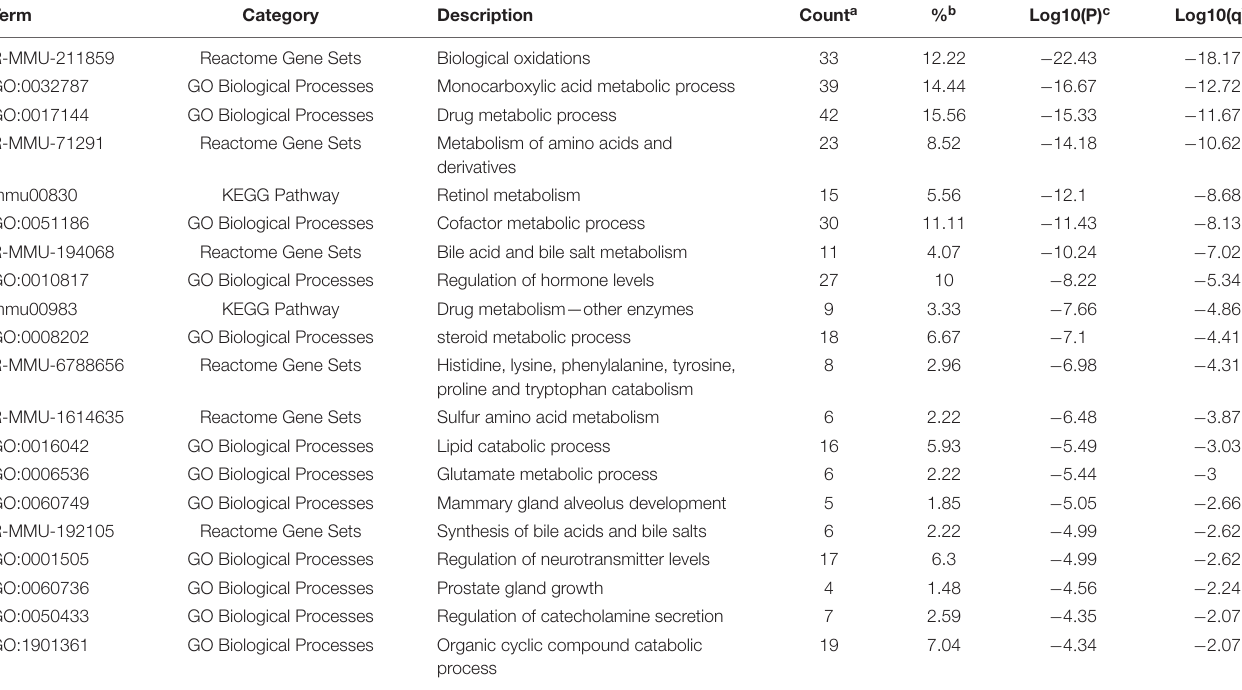
TABLE 1 | Top 20 clusters with their representative enriched terms of target genes of miRNA in DLK1-DIO3 DIR. Term